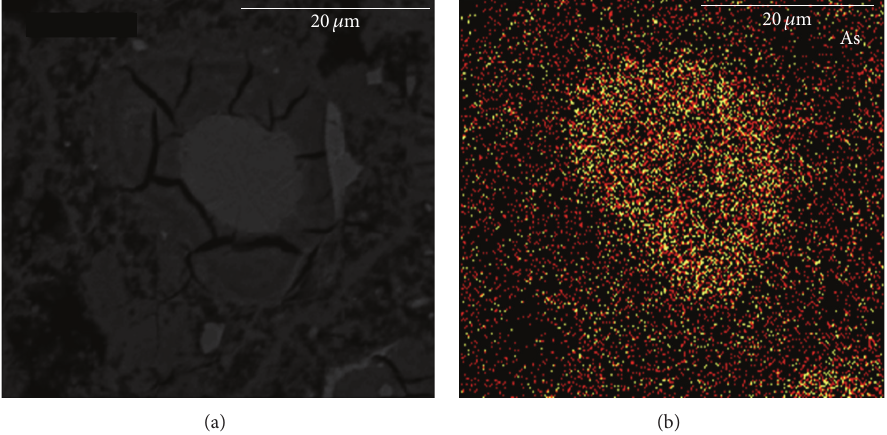
Figure 2: Typical feature of C-S-H gels in cement paste and the corresponding X-ray image of As.